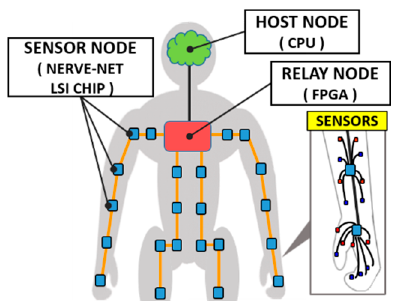
Figure 1. Image of Nerve-net tactile sensing on robot.